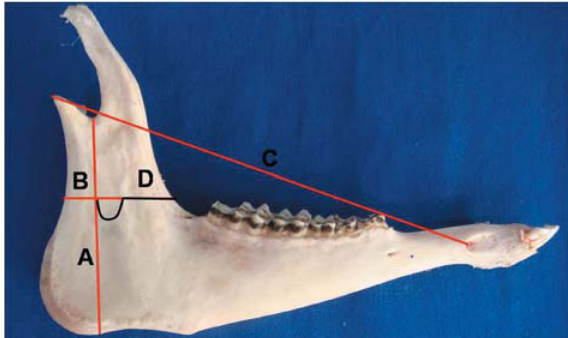
Figure 1- Mandible measures: (A) height of the ramus; (B) width of the ramus; (C) length of the mandible, (D) Distance between the anterior limit of the foramen and the mandible ramus